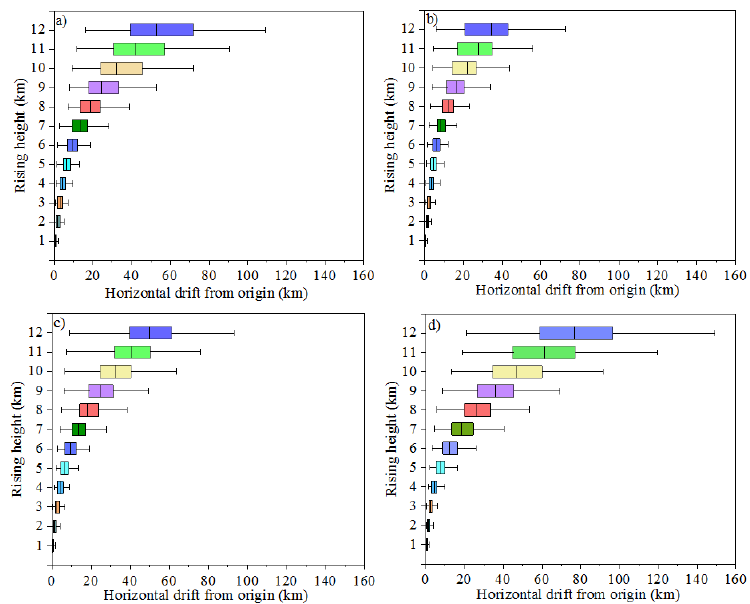
Figure 17. Horizontal drift of the radiosonde in its rising trajectory. ( a ) Spring, ( b ) summer, ( c ) au- tumn, and ( d ) winter (each boxplot shows the minimum, first quartile, median, third quartile, and maximum).